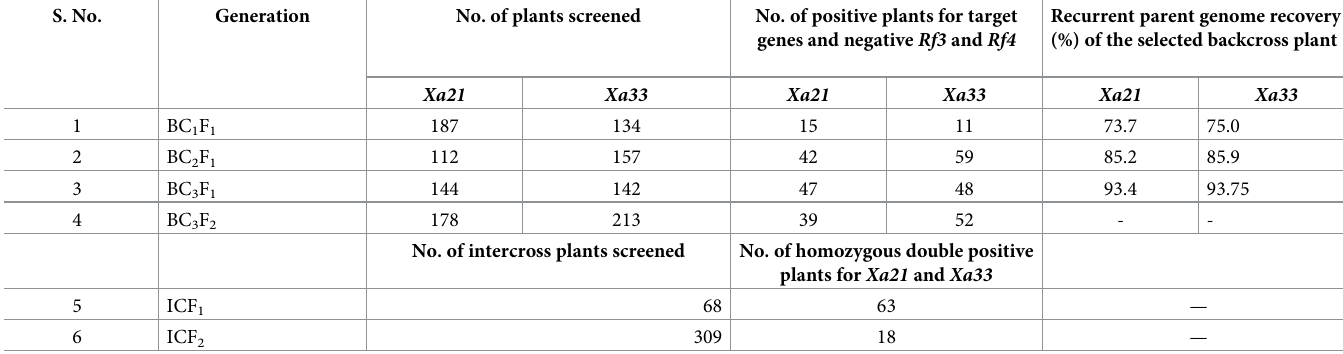
Table 2. Details of plants generated and analyzed with markers in each generation of backcrossing/intercrossing. S.